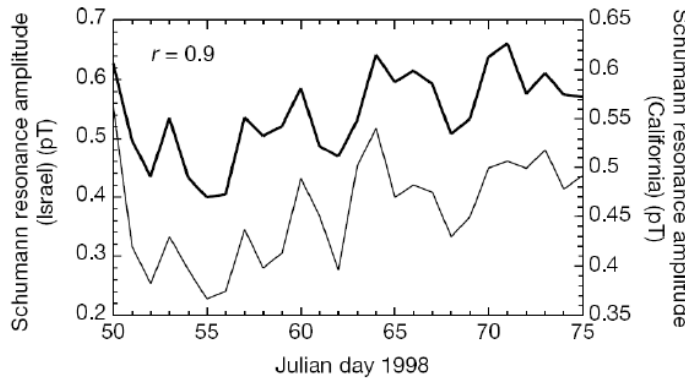
Figure 5. Comparison of the SR amplitude of the first mode (8 Hz) measured simultaneously in Israel and California [87].